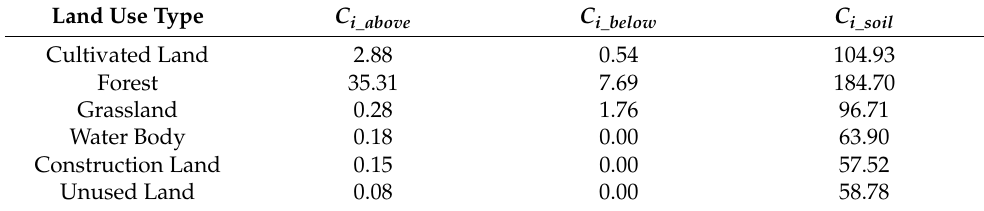
Table 4. Carbon density of different land use types (Mg/hm 2